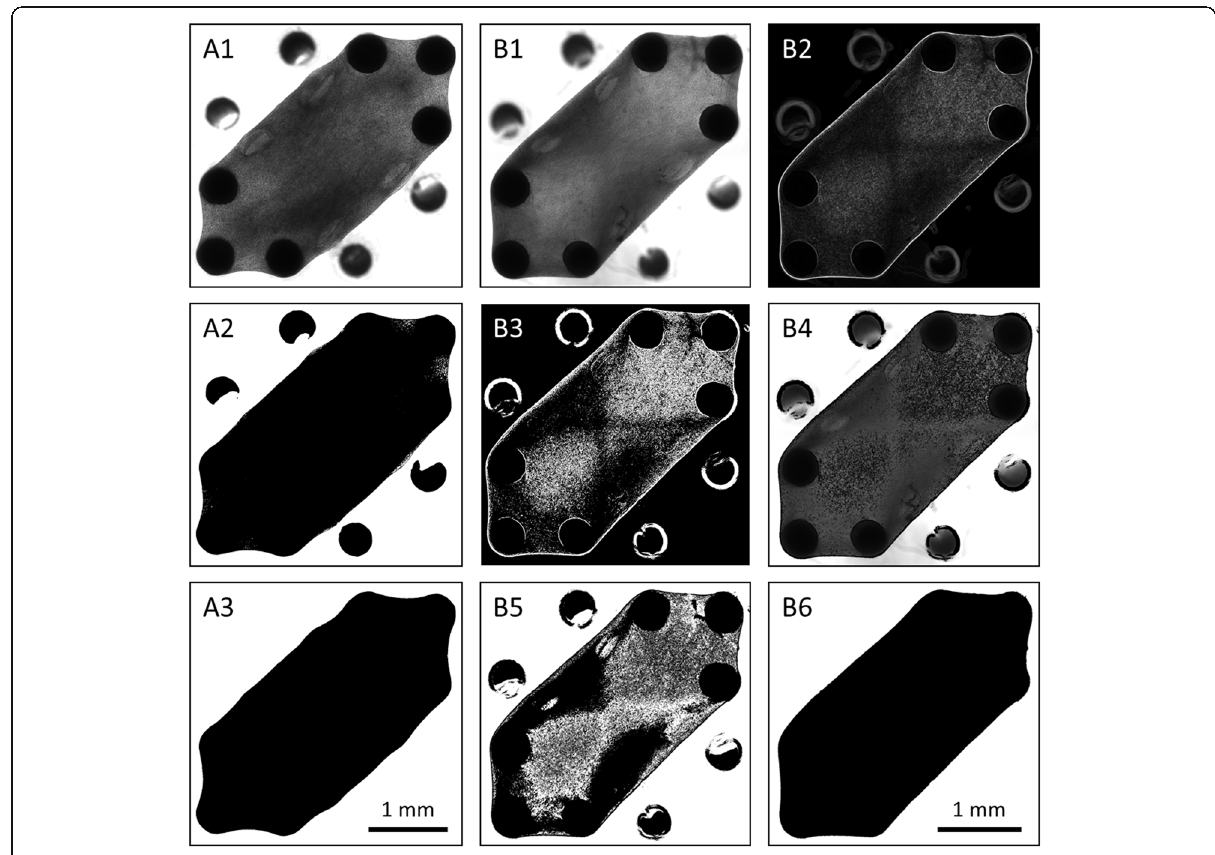
Fig. 2 Steps to obtain top-view micro-tissue surface area. (A) Based on absolute intensity values: the original image (A1) was binarized (A2), the largest connected component was selected, and any remaining holes were filled (A3). The object size (in pixels) was counted and converted to the absolute surface area. In case strategy A failed, strategy B was applied. (B) Based on micro-tissue: on the original image (B1) edge detection was performed (B2). Image 2 was binarized (B3), and subtracted from the original image (B4). The resulting image was binarized (B5), the